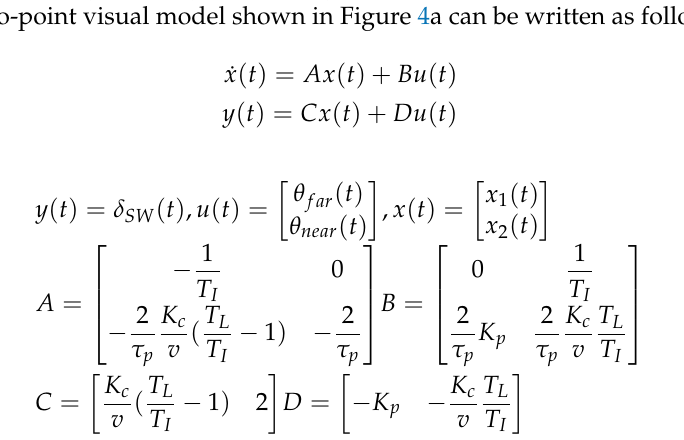
Table 1. Description of parameters in the model. Parameter Description Nominal Values K p Visual Anticipation Gain - K c Visual Compensation Gain - Compensation Time T I , T L Constants Processing Delay 0.04 Vehicle Longitudinal Speed